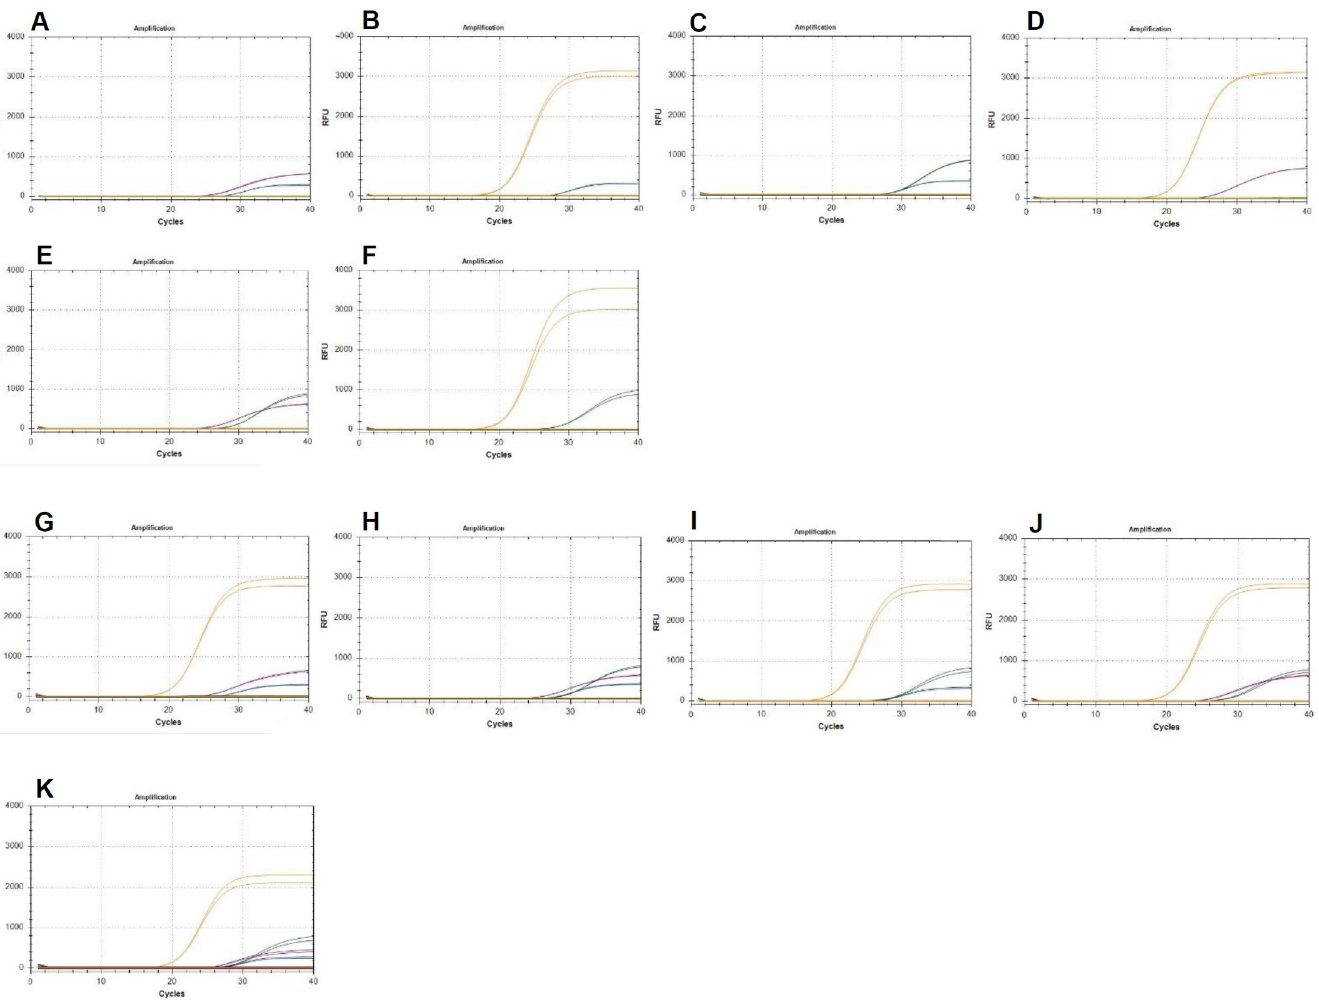
Fig 3. Parallel detection of two (A-F), three (G-J), or all four (K) different Diaporthe species. 0.4 ng DNA from (A) D . longicolla (blue) and D . caulivora (purple), (B) D . longicolla and D . eres (orange), (C) D . longicolla and D . novem (green), (D) D . caulivora and D . eres , (E) D . caulivora and D . novem , (F) D . eres and D . novem , (G) D . longicolla , D . caulivora , and D . eres , (H) D . longicolla , D . caulivora , and D . novem , (I) D . longicolla , D . eres , and D . novem , (J) D . caulivora , D . novem , and D . eres , and